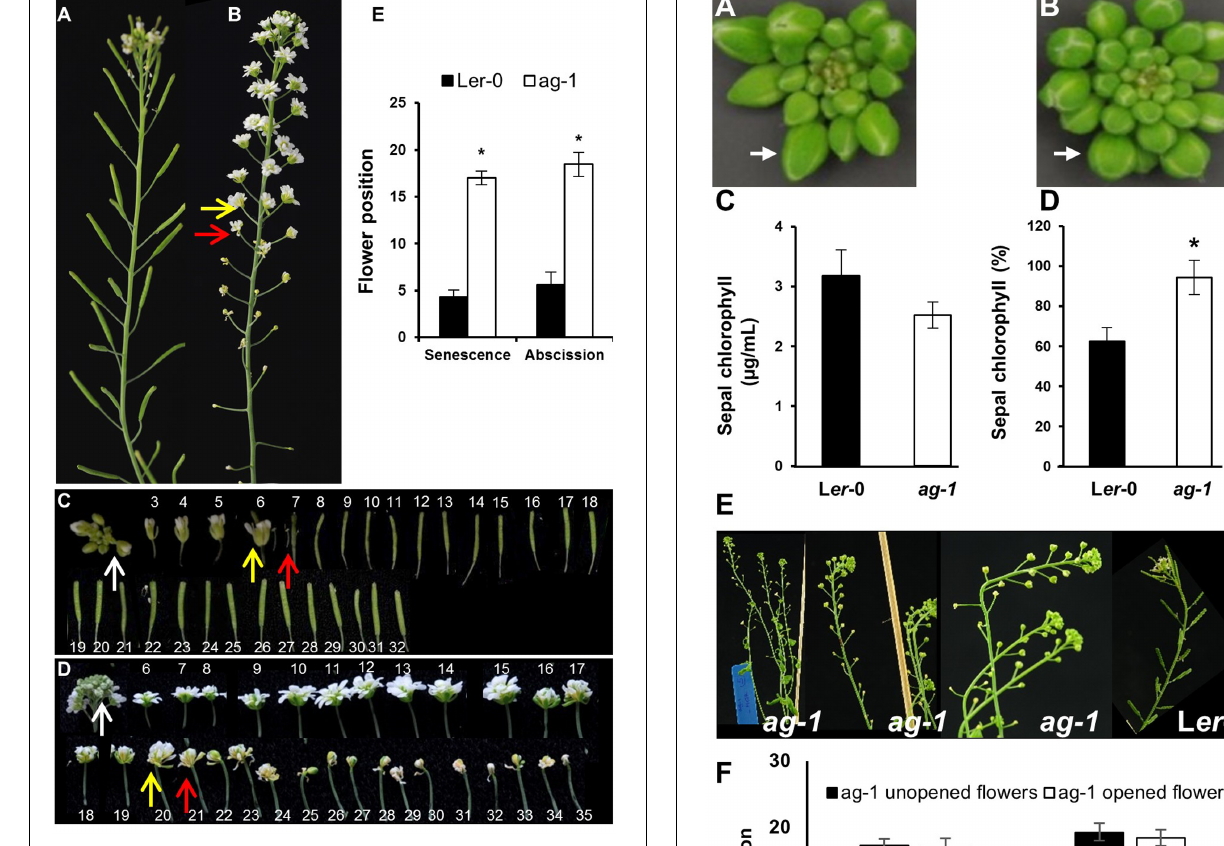
phenotypes in the ag-1 plants, further supporting the suggestion that decreased JA concentrations in ag-1 sepals are responsible for the delayed sepal yellowing and